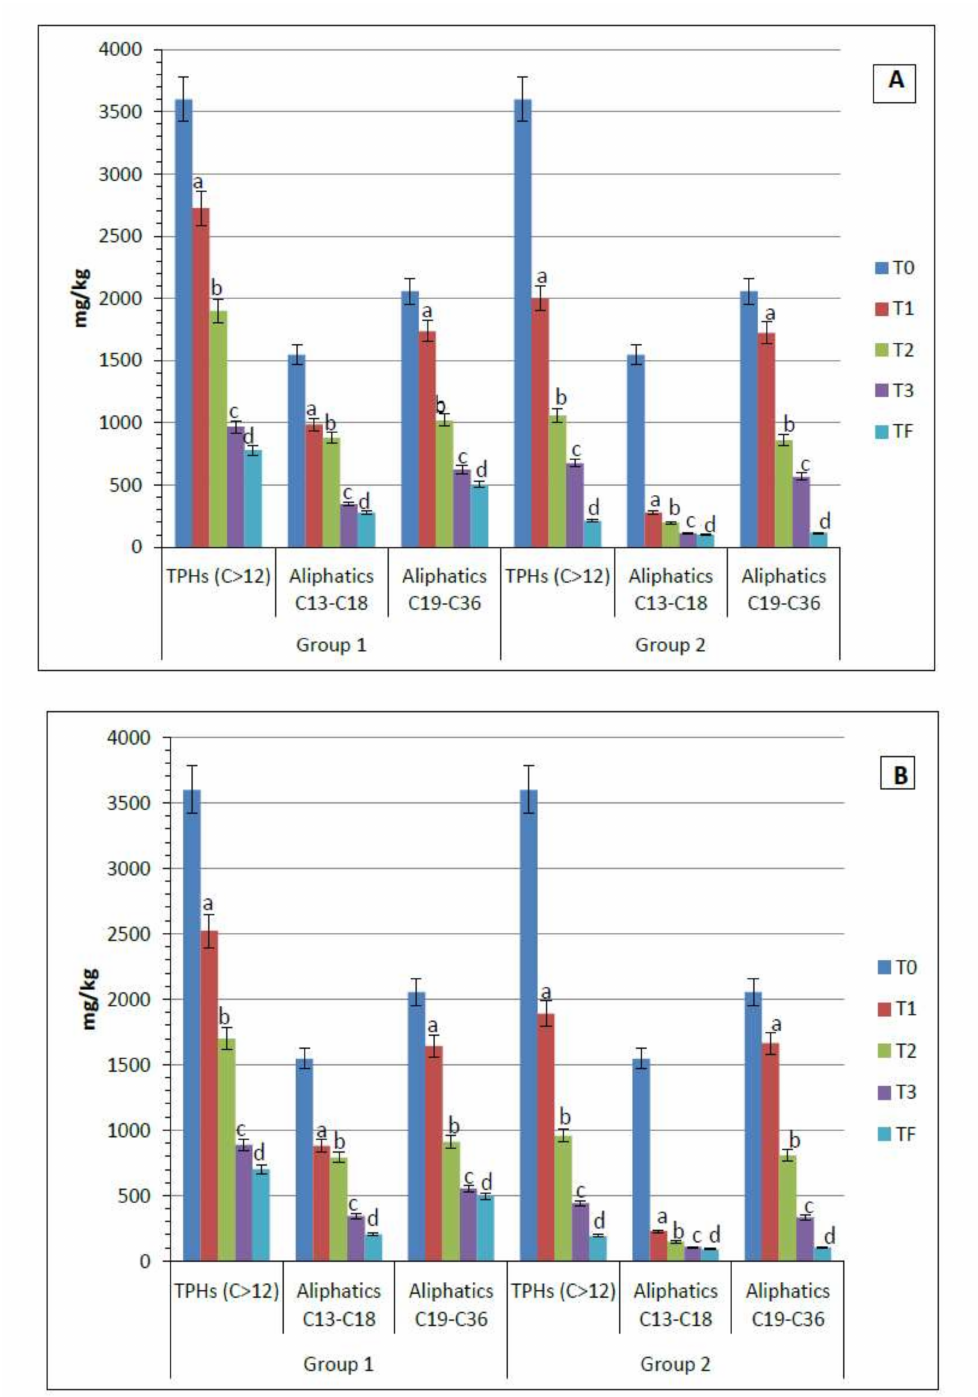
Figure 4. Total amount of TPHs, Aliphatic C13–C18 and Aliphatic C 19 –C 36 (mg / kg) in soil to Groups 1 and 2 after 30 (T 1 ), 60 (T 2 ), 90 (T 3 ), and 240 (T F ) days in soil mesocosms of ( A ) Oloptum miliaceum and ( B ) Pennisetum setaceum . Values represent mean ± SE. Di ff erent letters indicate means that are significantly di ff erent from each other (Duncan’s test, p <